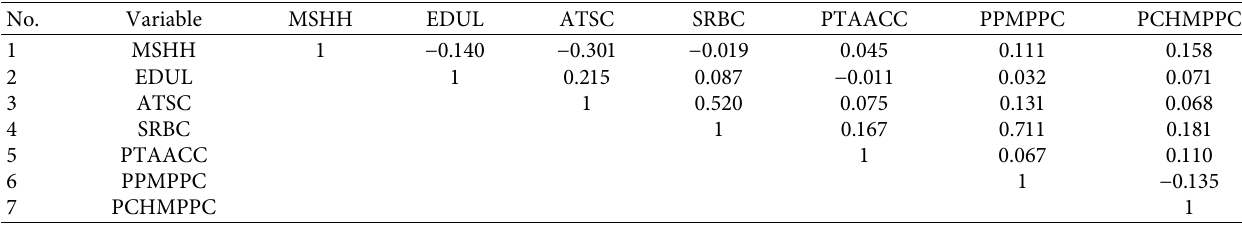
Table 14: Contingency coefficient for dummy/discrete